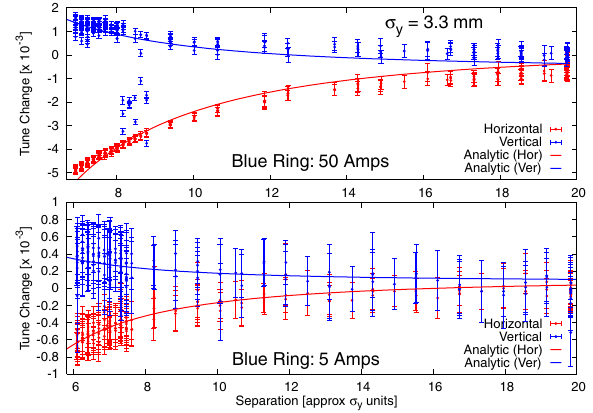
FIG. 12. Horizontal and vertical tune change for 50 A and 5 A wire current, for the Blue ring. Solid lines in all plots represent the analytical prediction.